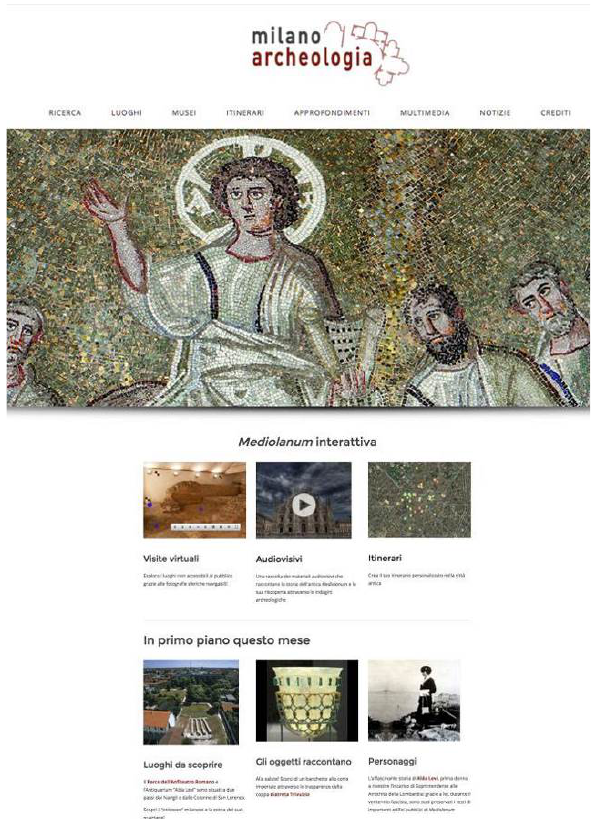
Figure 2. Home page of the “Milano Archeologia” web